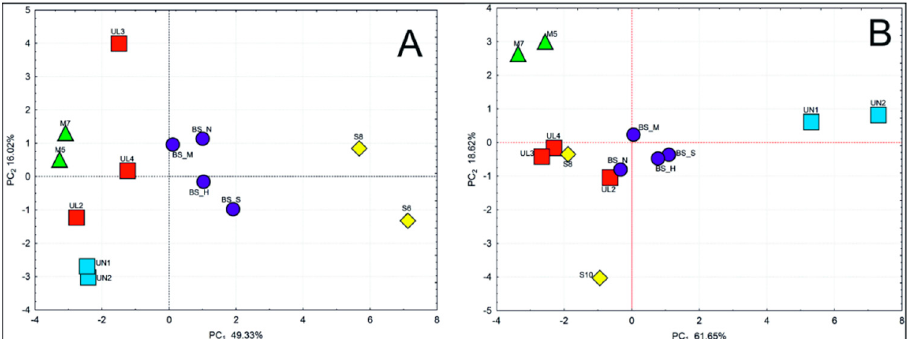
Figure 5. Principal component analysis (PCA) plot showing relationships between groups of samples defined at the mixed pine population in Bł˛edne Skały as P. sylvestris (BS_S), P. uliginosa (BS_M), hybrids (BS_H), undetermined (BS_N) and reference populations of the four pine species (population acronyms as in Table 1): ( A ) based on needle traits; ( B ) based on cone